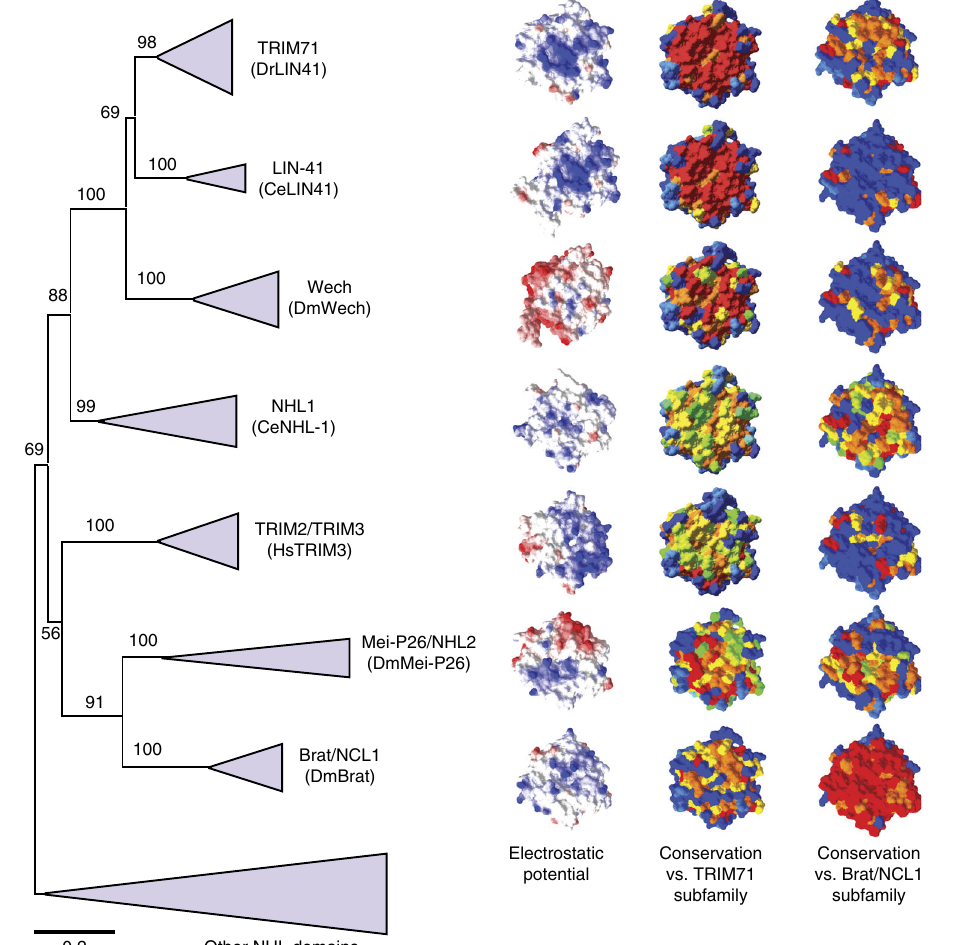
Fig. 9 Evolutionary relationships between NHL domains. Left: a simpli fi ed phylogenetic tree of NHL domains, with a focus on putative RNA-binding proteins. For details, see Supplementary Fig. 5. Branches comprising multiple sequences from one subfamily (named after a representative protein) have been collapsed and are illustrated as triangles. The apex of a triangle indicates the start-point for an individual branch, whereas the width of the base indicates the number of the members that constitute the branch. The tree is drawn to scale, with branch lengths in the same units as evolutionary distances used to build the phylogenetic tree. Bootstrap values are shown for all nodes. Right: structural characteristics of the selected representatives of the seven subfamilies; from top to bottom: DrLIN41, CeLIN41, DmWech, CeNHL-1, HsTRIM3, DmMei-P26, and DmBrat. All structures are shown in surface representation. The left column depicts either experimentally determined crystal structures (DrLIN41 and DmBrat), or computationally modeled 3D structures of the proteins, with the mapped electrostatic potential on the solvent accessible surface from – 5 kT/e (red, acidic) to + 5 kT/e (blue, basic). The middle column depicts the sequence conservation within the TRIM71 subfamily (top image) and between the TRIM71 subfamily and each of the other subfamilies, mapped on the DrLIN41 crystal structure. The right column depicts the sequence conservation within the Brat subfamily (bottom image) and between the Brat subfamily and each of the other subfamilies, mapped on the DmBrat crystal structure. The middle and right panel use the same coloring scheme: red for invariant residues (within the reference subfamily, i.e., TRIM71 or Brat, respectively, or between the reference family and the compared subfamily), orange and yellow for partially conserved residues, green for weakly conserved residues, and blue for non-conserved